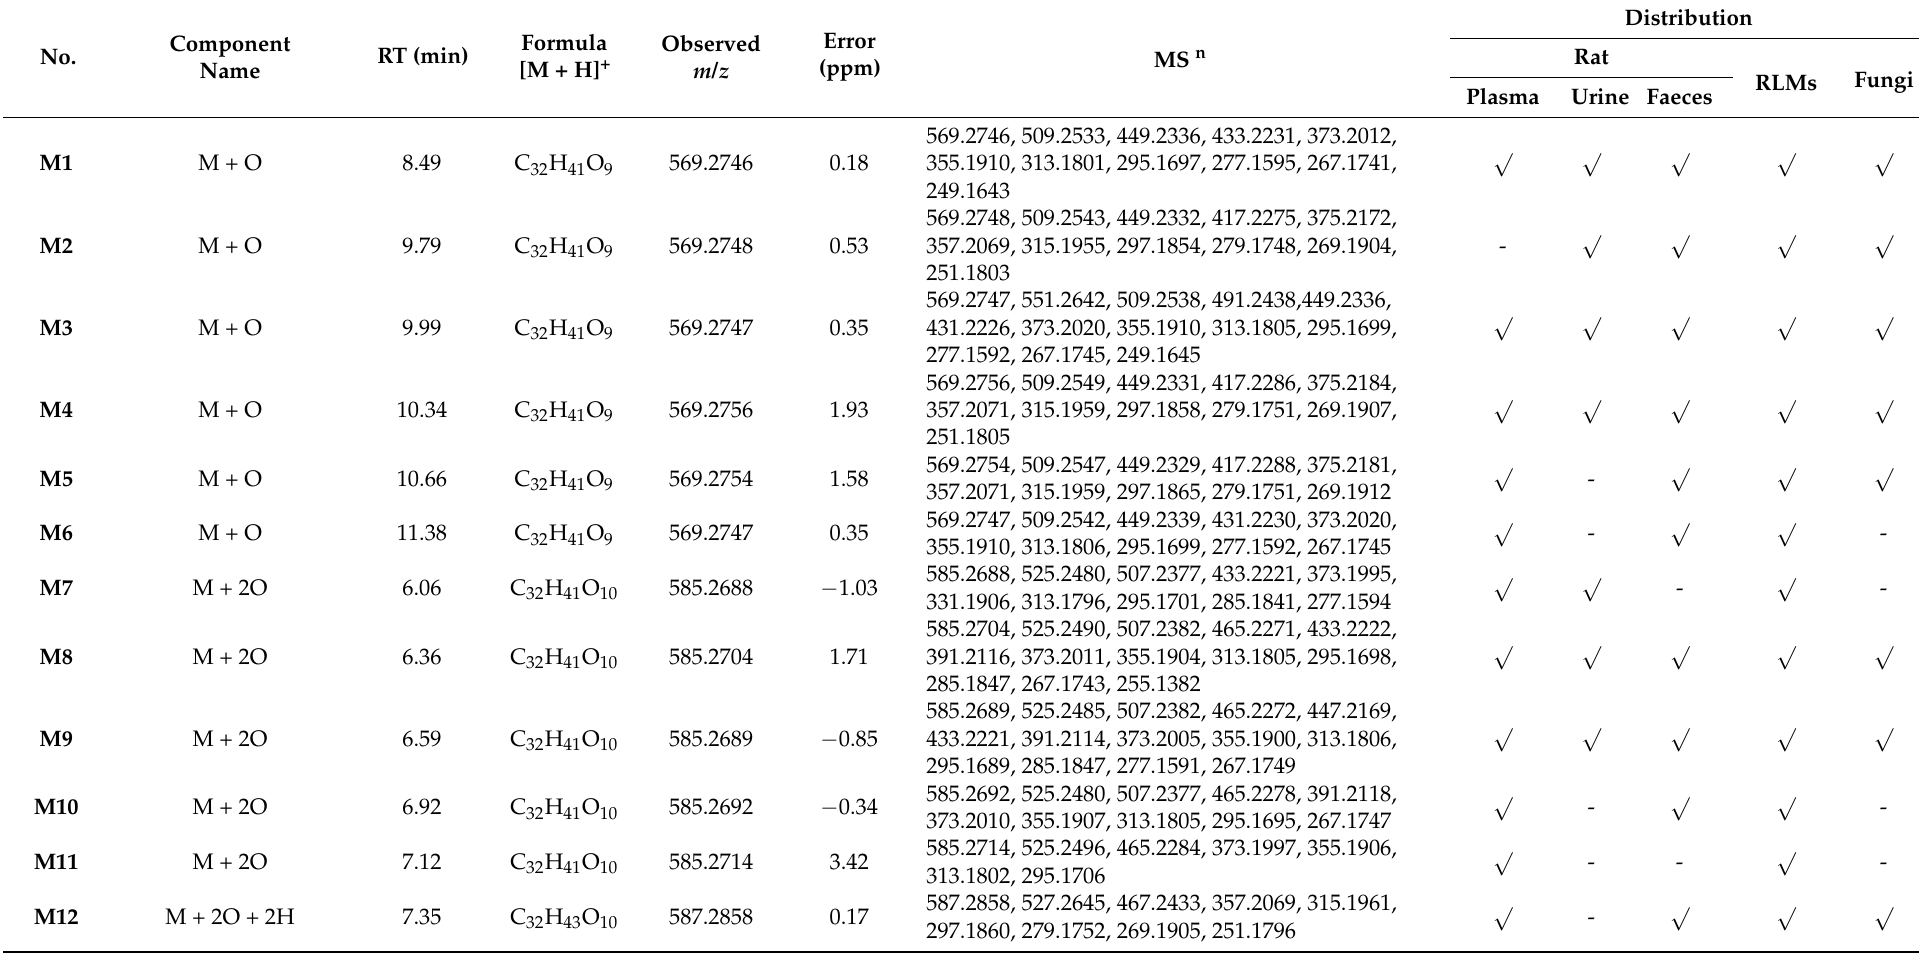
Table 4. Mass spectrum characteristics of metabolites of euphorbiasteroid detected in vivo and in